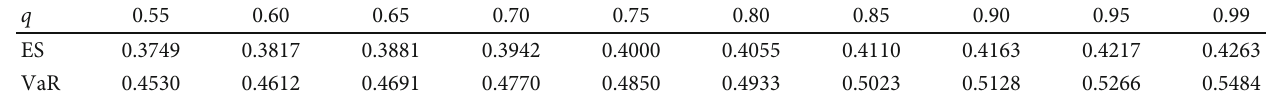
Table 2: Numerical illustration of ES and VaR of UPWD based on MLE values of insurance